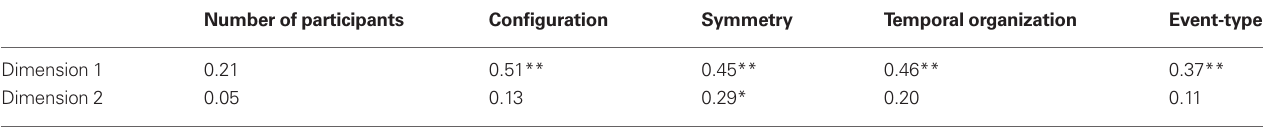
Table 2 | Correlation of videoclip loadings on MDS analysis in Figure 5 and event parameters from Table 1